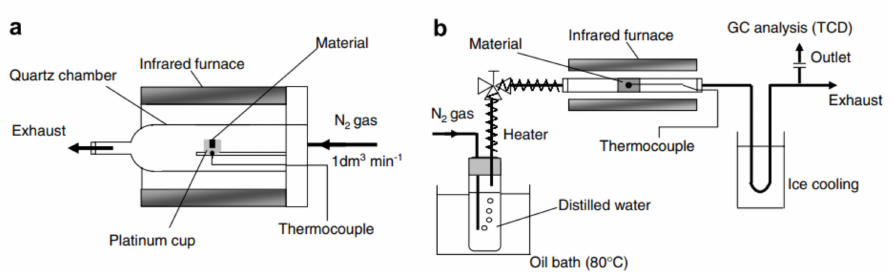
Figure 7. Schematic representation of the experimental setup used for ( a ) thermochemical reduction of Fe 3 O 4 supported on yttria-stabilized zirconia and Ni x Fe 3 − x O 4 supported on monoclinic zirconia, as well as ( b ) oxidation of Ni x Fe 3 − x O 4 supported on monoclinic zirconia. The reduction temperature was 1400 ◦ C and the oxidation temperature was 1000 ◦ C for both redox materials. Reprinted from